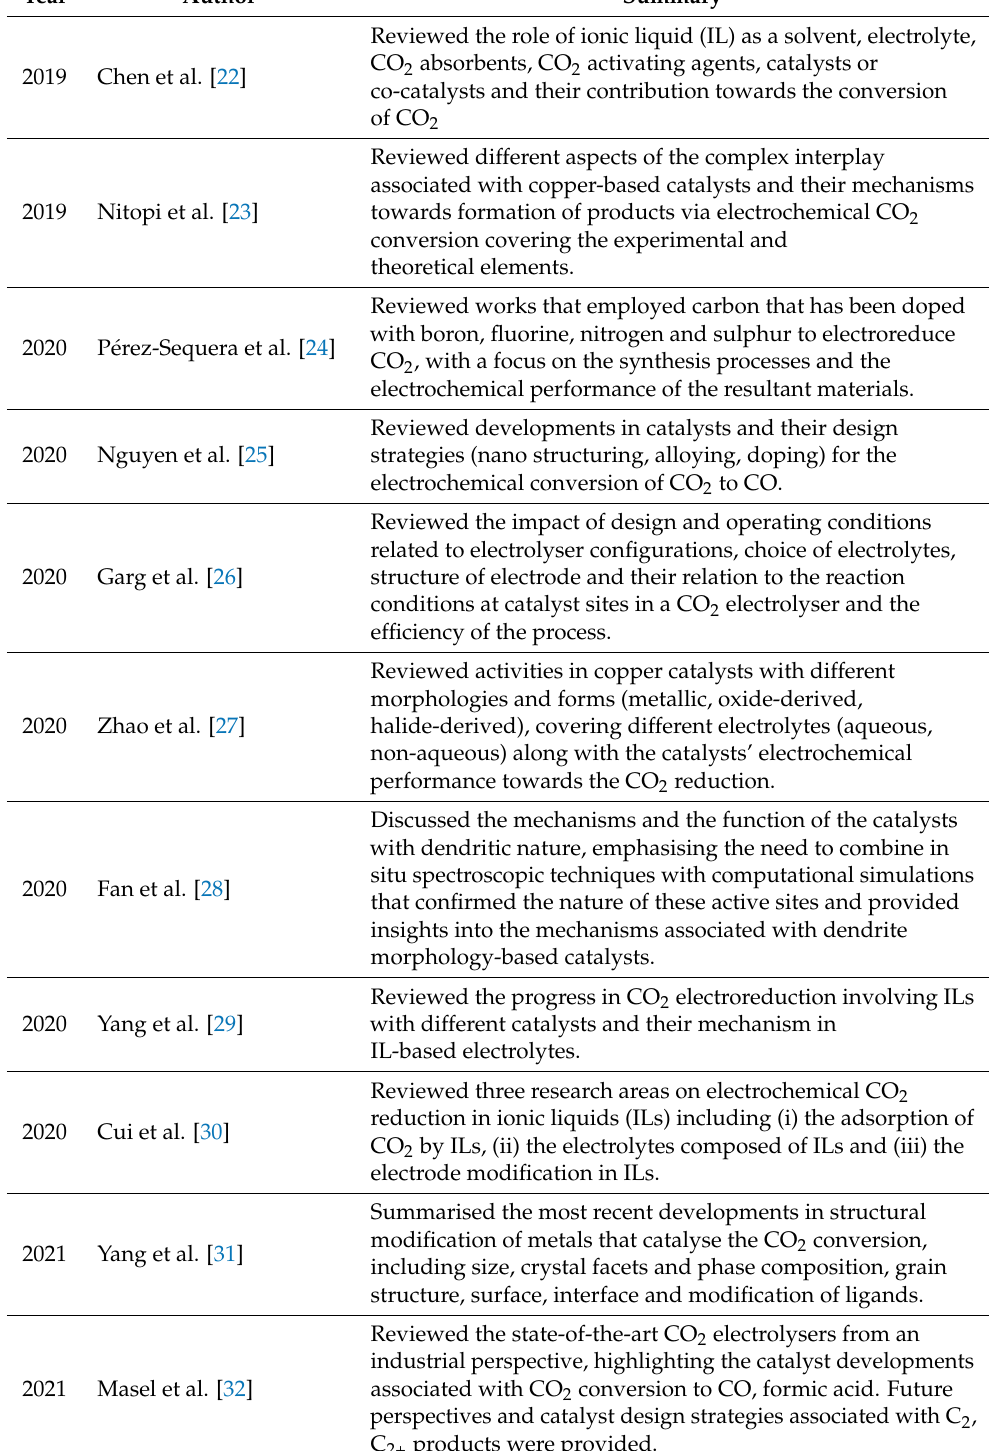
Table 1. Key reviews published during 2019–2022 along with their